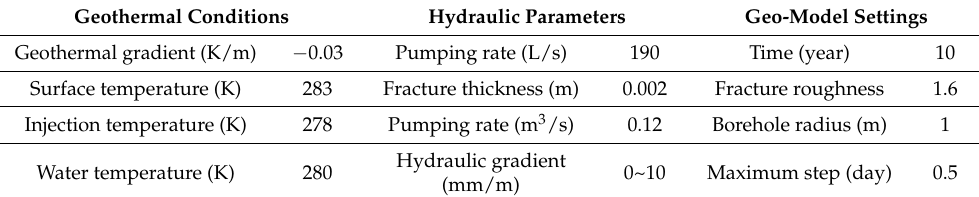
Table 1. Parameters of geo-model.